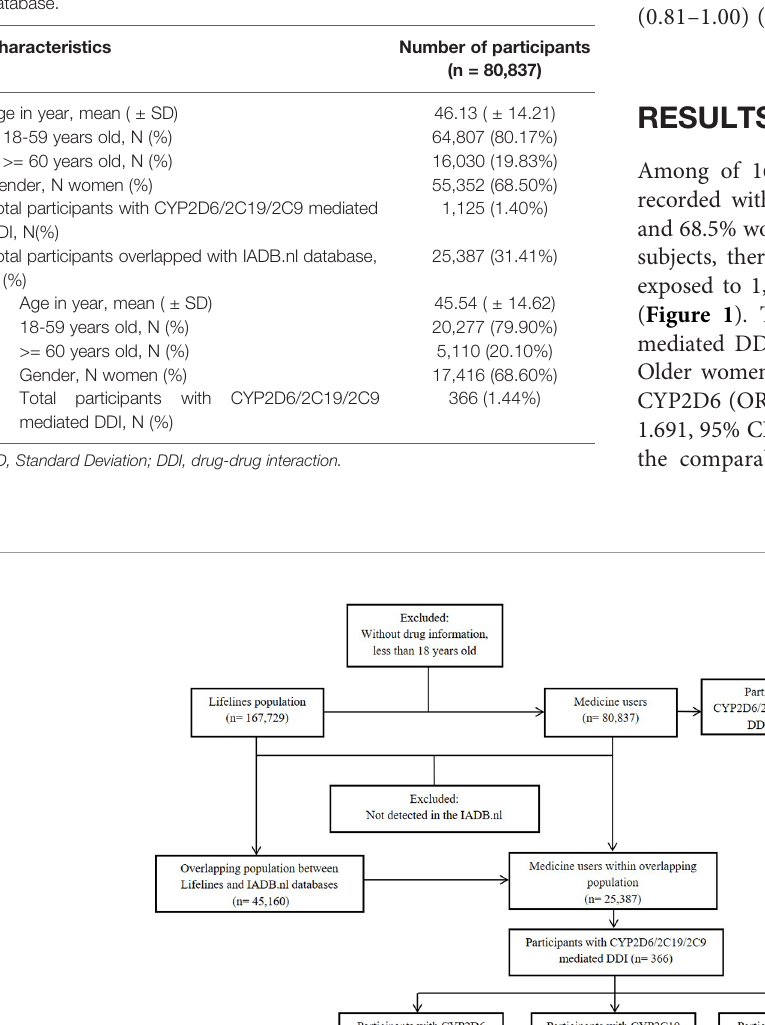
TABLE 1 | Characteristics of participants with self-reported medication use at entry in the Lifelines cohort database and overlap with IADB.nl prescription